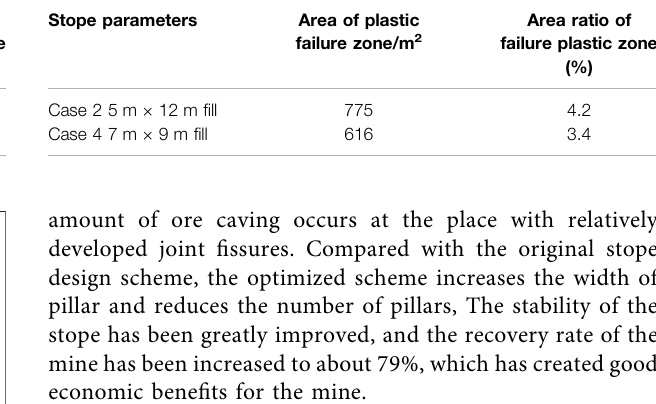
TABLE 5 | Area ratio of plastic zone under case 2 and case 4. TABLE 4 | Area ratio of plastic zone under case 1 and case